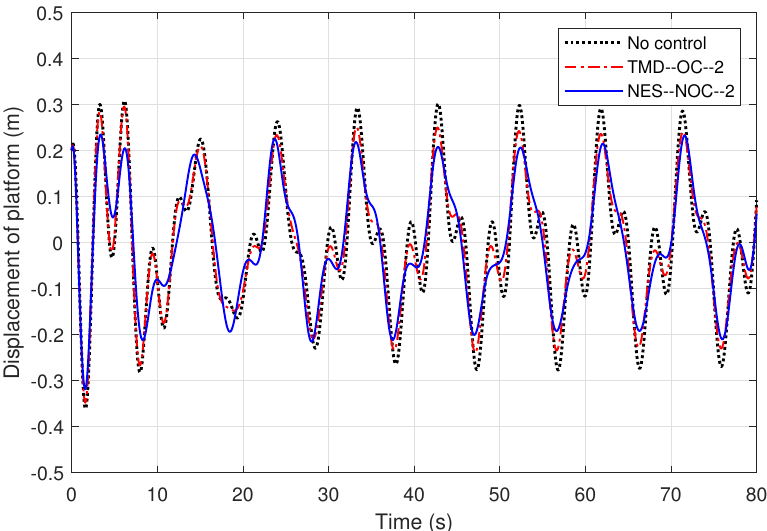
Figure 16. Displacements of the structure without control, with TMD–OC–2 and